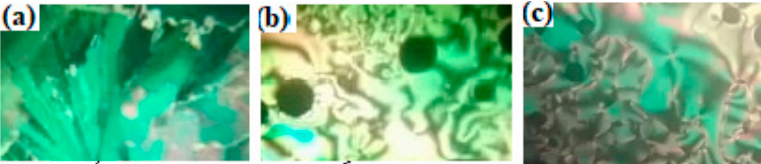
transition; and N–I = N to isotropic liquid transition .